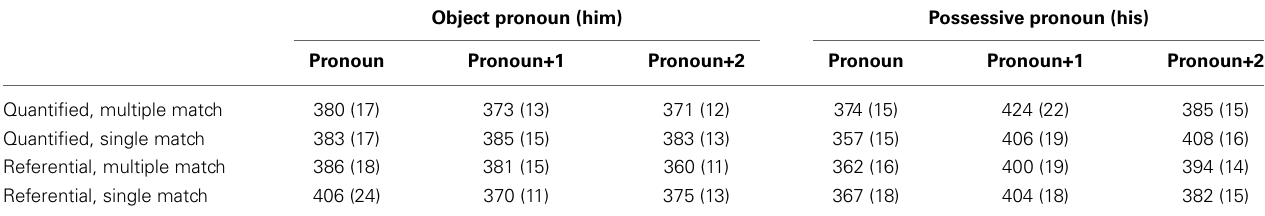
Table 6 | Grand average reading times in each ROI across all conditions in Experiment